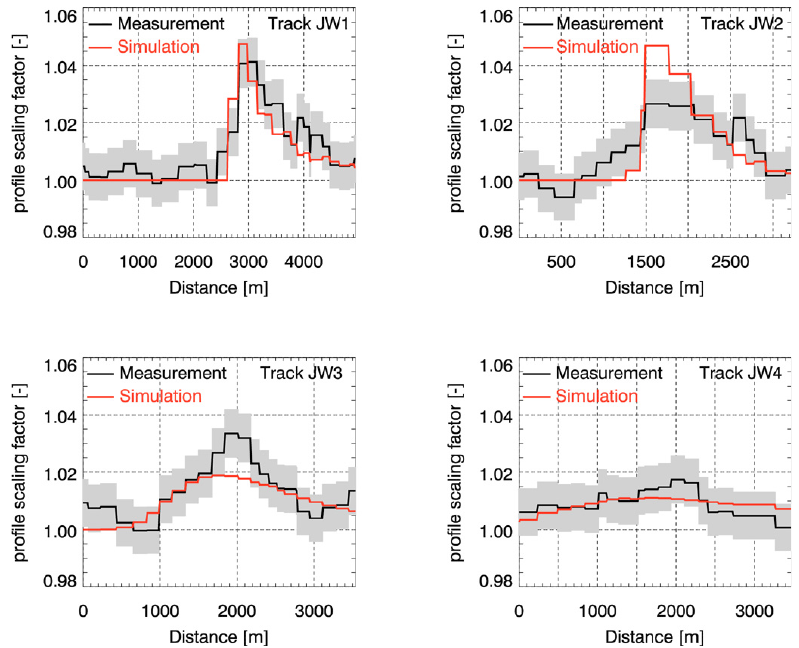
Fig. 8. The figure shows model data (red) computed from the inversion result for the Gaussian plume model and measurements (black) in case of J¨anschwalde power plant along horizontal cross sections through the CO 2 plume. Statistical errors are shown in grey. For the track numbers compare Fig. 3.